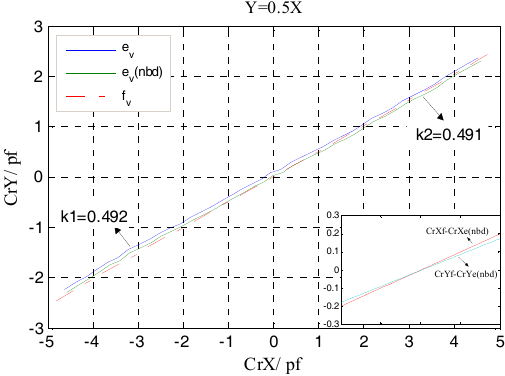
Figure 24. The curve of CrY/CrX in the single radial runout direction.